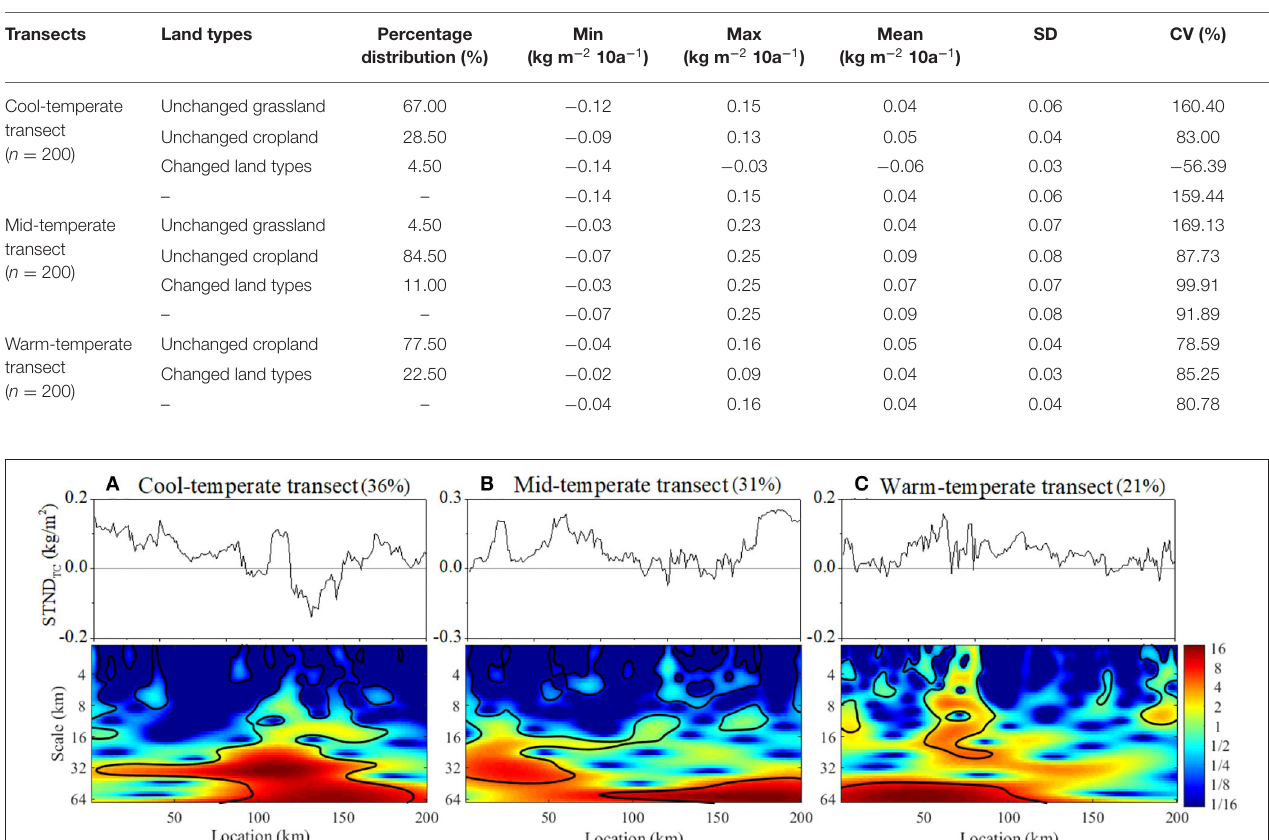
TABLE 2 | Significant spatial variations of temporal changes of soil nitrogen density (SND T ) under different land types along the three transects. Transects